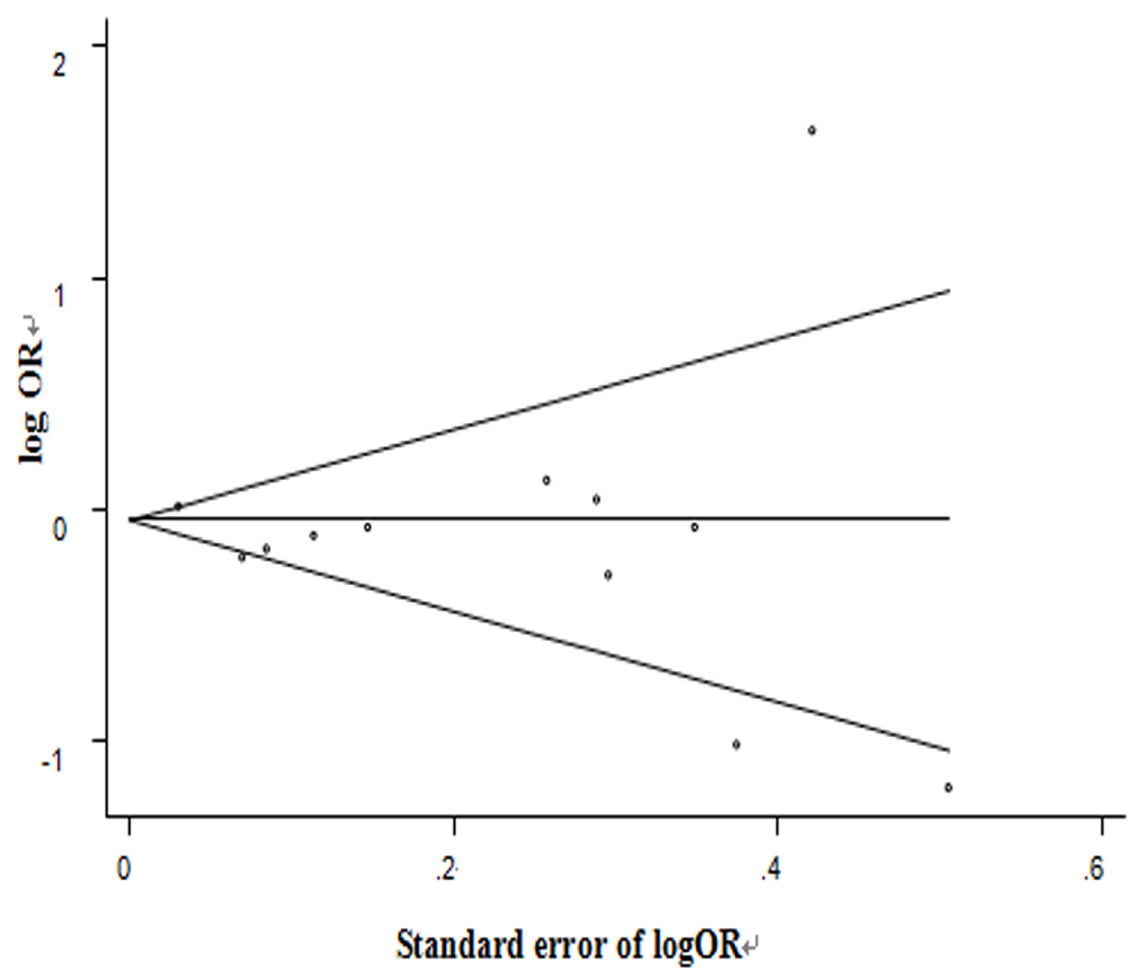
Figure 6. Begg’s funnel plot (with pseudo 95% confidence intervals) to detect any publication bias. doi: